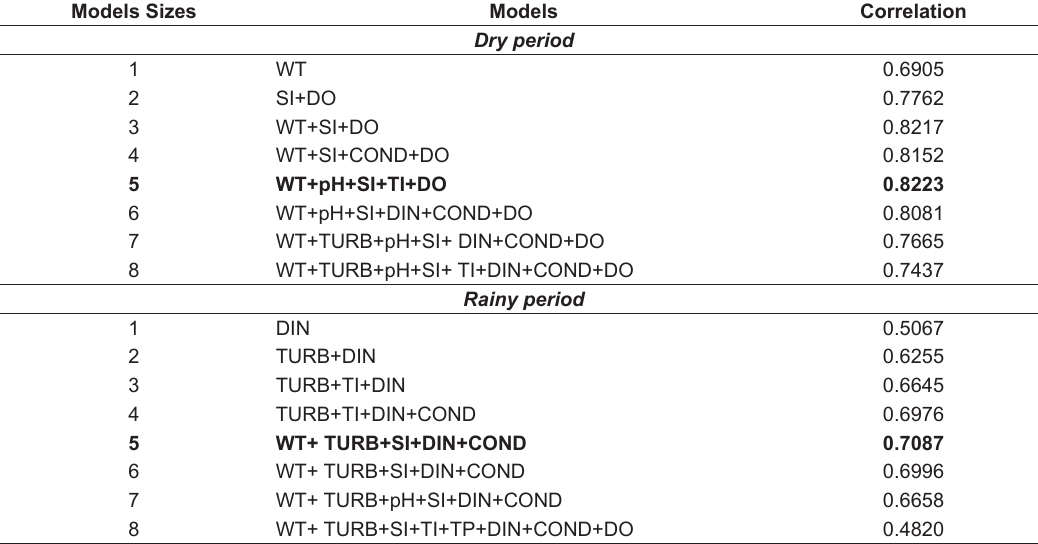
Table 2. Results of the BioEnv for phytoplankton presence/absence during a dry and rainy period in the João Leite reservoir.